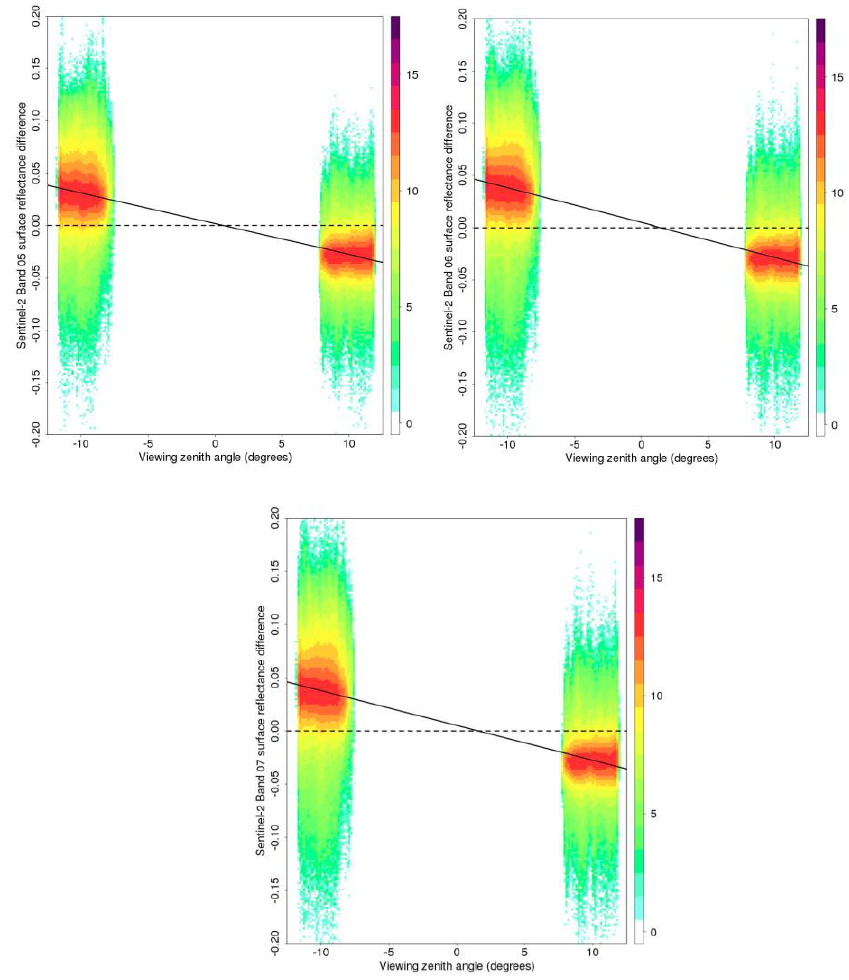
Figure 4. Sentinel-2A MSI red-edge surface reflectance differences in the Southern Africa January swath image overlap zones plotted against view zenith for a total of 6,600,685 pairs of forward and back scatter surface reflectance values. The plot colors show the relative frequency of occurrence of similar difference values (with a log2 scale). The solid lines show ordinary least squares (OLS) linear regression fits of these data (see Table 4). Results shown for MSI bands 5 (705 nm), 6 (740 nm), and 7 (783 nm).